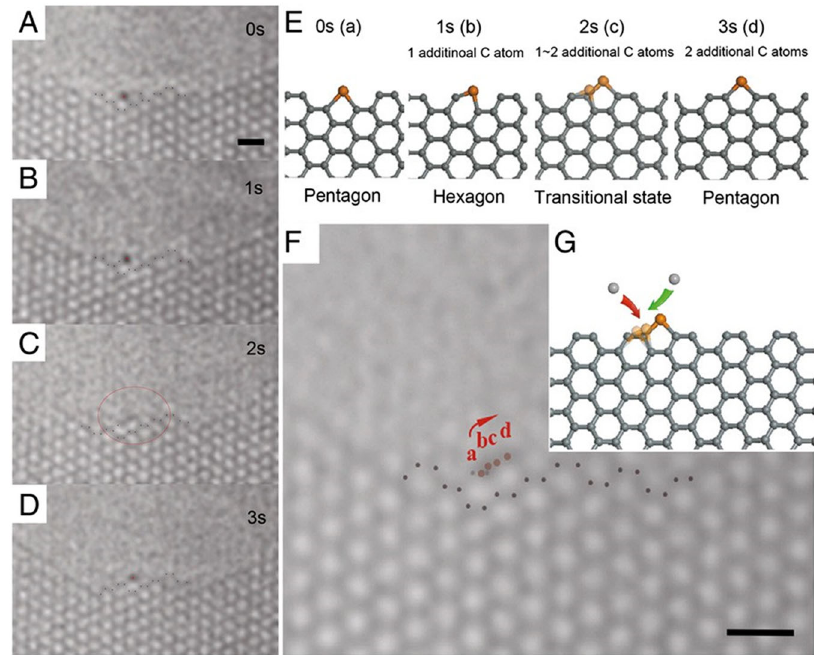
Fig. 4 One cycle of catalytic growth of graphene edge. A – D A series of high-resolution TEM images or 4 s; the Fe atom is highlighted as a red dot, whereas the nearby carbon atoms are highlighted as black dots. The dark shadow line, which is highlighted by the red circle in ( C ), is because of the motion of the Fe atom during exposure time. (Scale bar: 0.5 nm.) E The corresponding atomic structures for ( A – D ). F The combination of ( A – D ), which shows the trace of the Fe atom during the one-unit cell translocation. (Scale bar: 0.5 nm.) G The atomic structure for the whole growth process (two carbon atoms are added). Reproduced with permission from National Academy of Sciences 43